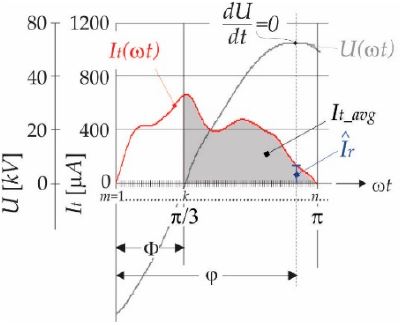
Figure 4. Description of average value I t_avg and its relation with pair ( ϕ , ˆ I r ). Table 3. Resume of the calculated average values of leakage current I t , measured with an oscilloscope in the intervals 60 ◦ ≤ ϕ ≤ 180 ◦ ( π /3 ≤ ω t ≤ π ) , according to the relation I t _ avg = I t _ avg ( ϕ ) . Sample 1